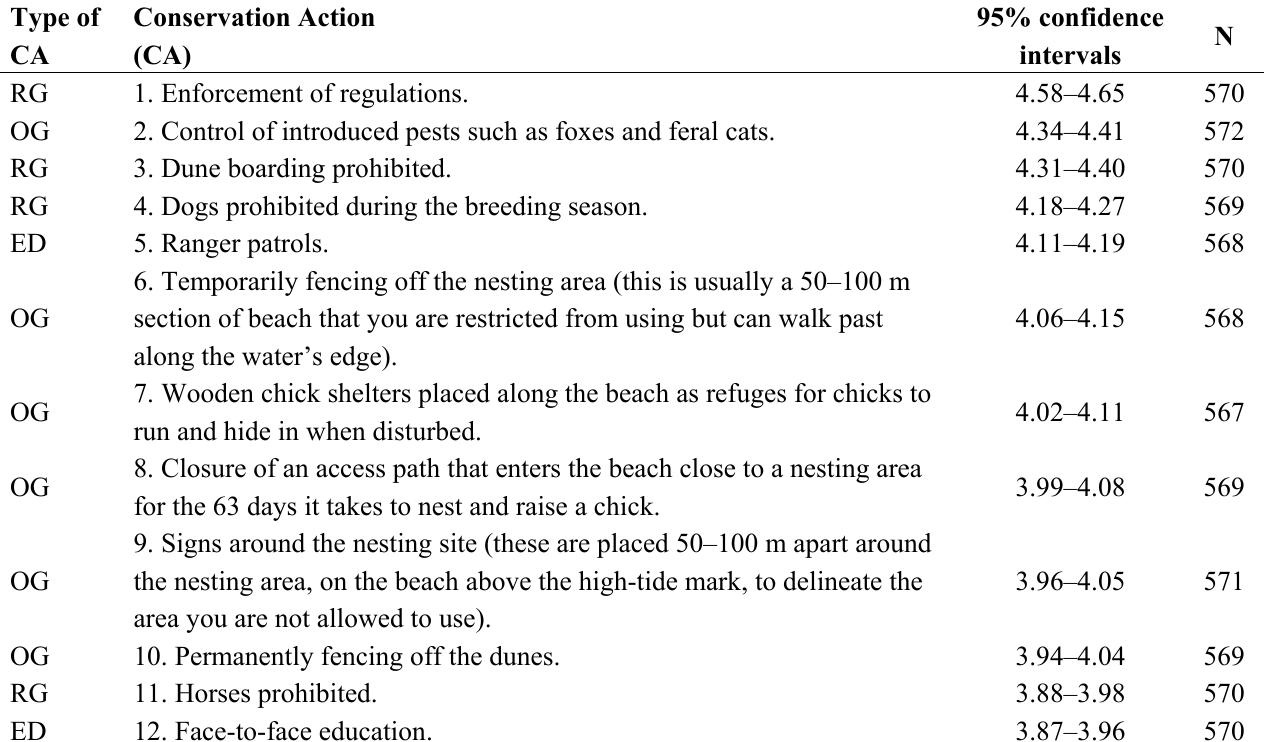
Table 4. Respondent ratings of the perceived effectiveness of 23 conservation actions at improving plover reproductive success, on a scale from 1 (“not very effective”) to 5 (“very effective”). Conservation actions are categorised as OG (on-ground actions), RG (regulations) and ED (education/awareness raising